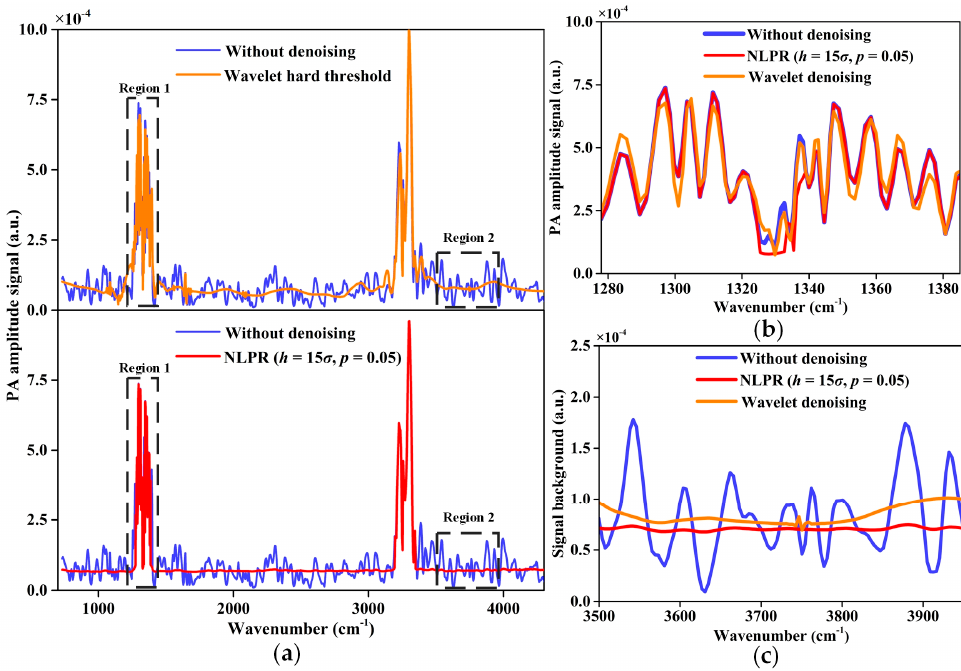
Figure 5. ( a ) Comparison of denoised 100 ppm C 2 H 2 PA signals with NLPR algorithm and wavelet hard threshold denoising method. ( b ) Enlargement of region 1 for the comparison of the absorption peak fidelity; ( c ) enlargement of region 2 for the comparison of background noise removal performance.